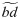
Links between binding of RBPs and kinetic rates of mRNA.(A) Log2-transformed ratios of median transcription rates of genes bound (bd˜) and unbound (ubd˜) by RBPs as indicated. (B) Log2-transformed mean Pol II pausing indices of transcripts bound by each RBP (bd¯). (C) Same as (A), but for export rates. RBPs with roles in splicing are marked by "x". (D) Same as (A), but for decay rates. RBPs in all the panels are ranked according to their associated values, but colors are same as in (A). RBP binding data was taken from [31]. RBPs of which binding is significantly associated with rates of transcription (A), pausing index (B), export (C) and cytoplasmic decay (D) are marked by (*) (P < 0.01, two-sided Wilcoxon test, adjusted by the Holm—Bonferroni method).